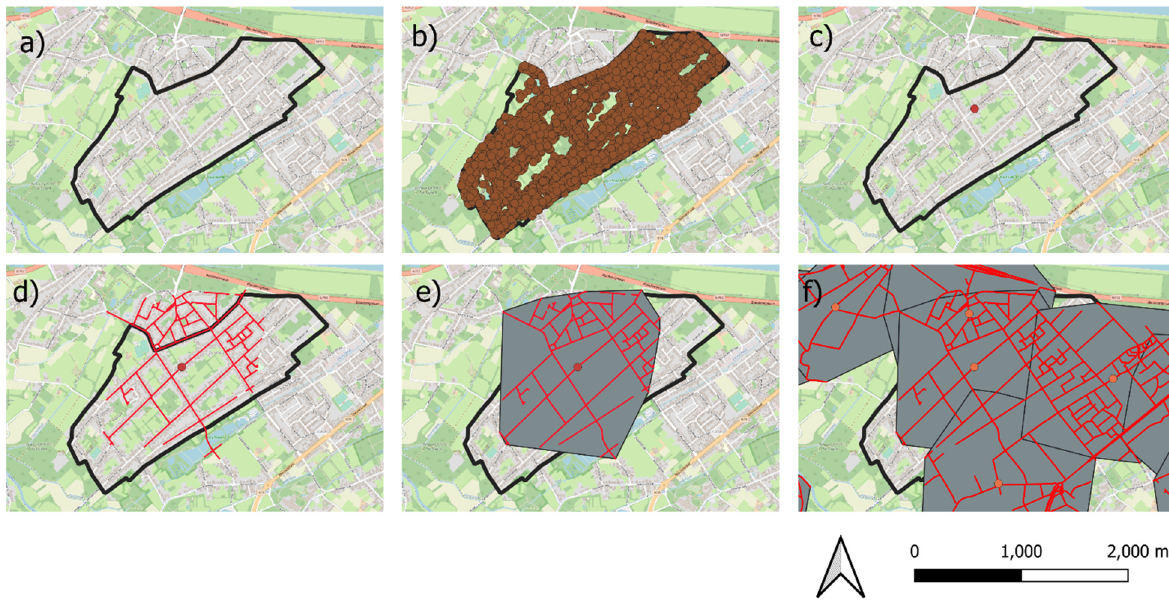
Figure 3. Procedure to create the residential areas. A census tract ( a ) was filtered to only contain the points of the modified CRAB database, depicting the residential addresses ( b ). The geometric center of gravity was calculated for these points ( c ). Next, the 1000 m road distance from the geometric center of gravity was calculated ( d ). A buffer containing the 1000 m road distance measurement was created, resulting in the residential areas ( e ). This procedure was carried out for each census tract in Flanders with residential buildings ( f ). Note that the residential areas often overlap.